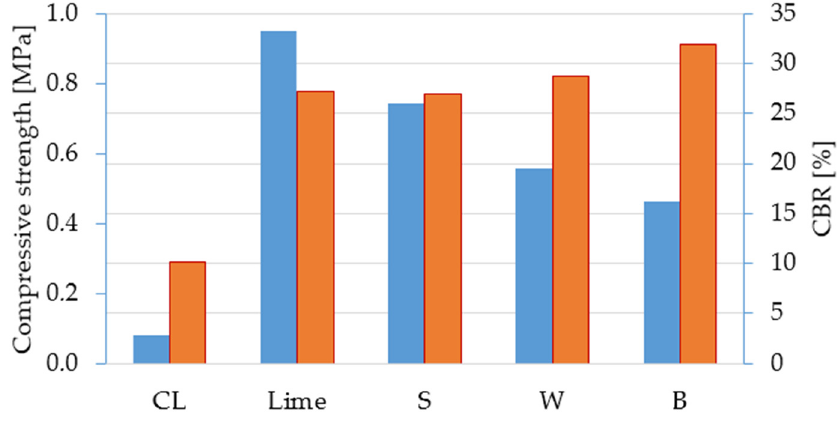
Figure 5. Results of CBR and compressive strength